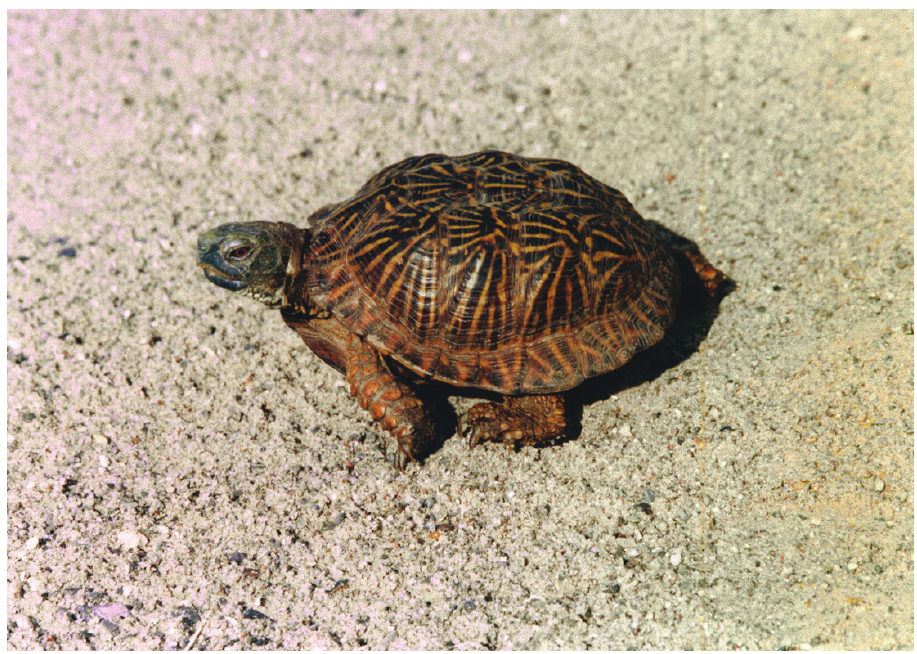
Figure 3. Terrapene ornata . Rancho de Flores Magón, Buenaventura, Chihuahua. Photo by Julio Lemos